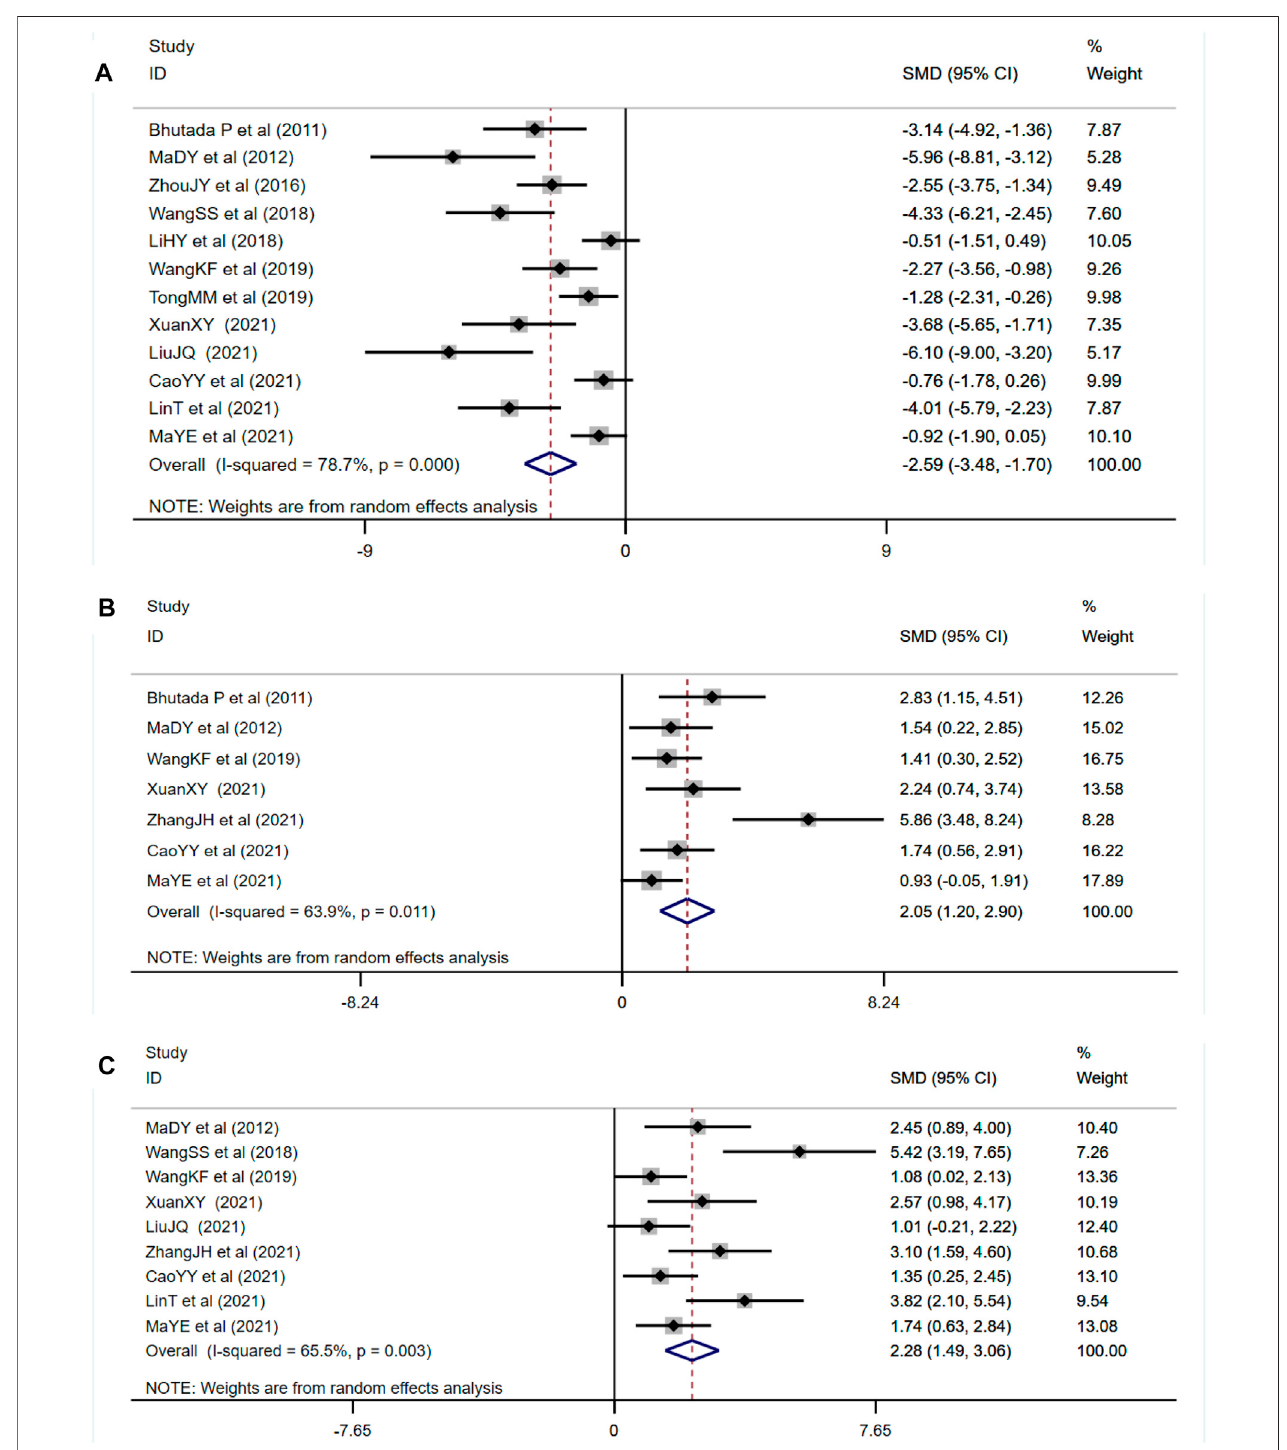
FIGURE 4 | Forest plot: effect of berberine on (A) escape latency, (B) times of crossing the platform, and (C) time spent in the target quadrant.